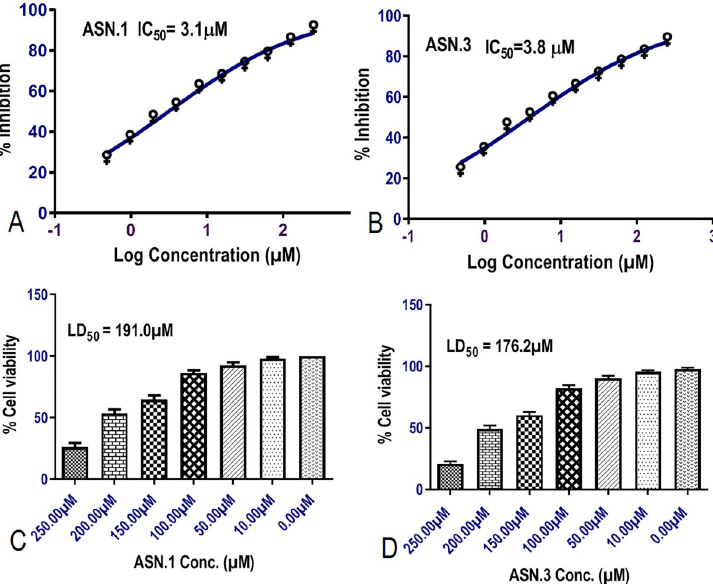
Fig 8. Showed gametocidal activity of primary hits against RKL-9 strain in terms of IC 50 (A, B) . MTT toxicity of primary hits against HEK-293 cells with P ��� (p > 0.001) (C, D)